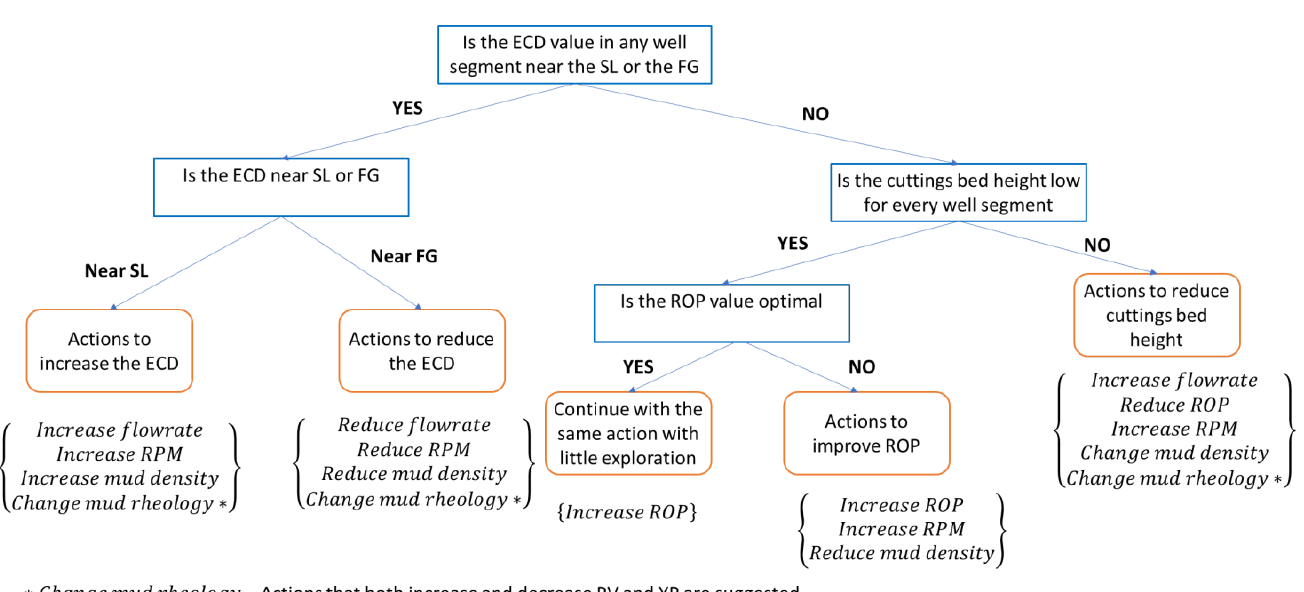
Figure 9. A simplistic representation of an action selection decision-tree for satisfying safety and performance metrics.